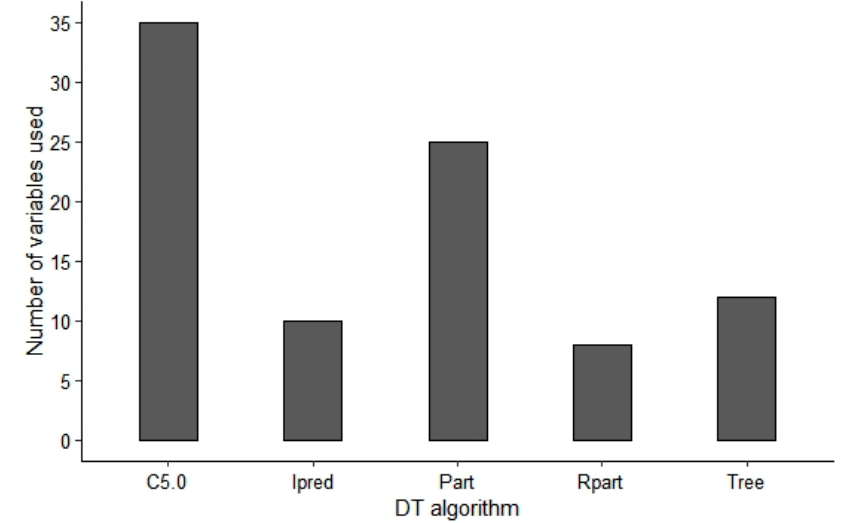
Figure 5. Figure 5. Thematic map classification accuracies (%) and the number of variables used during classification.